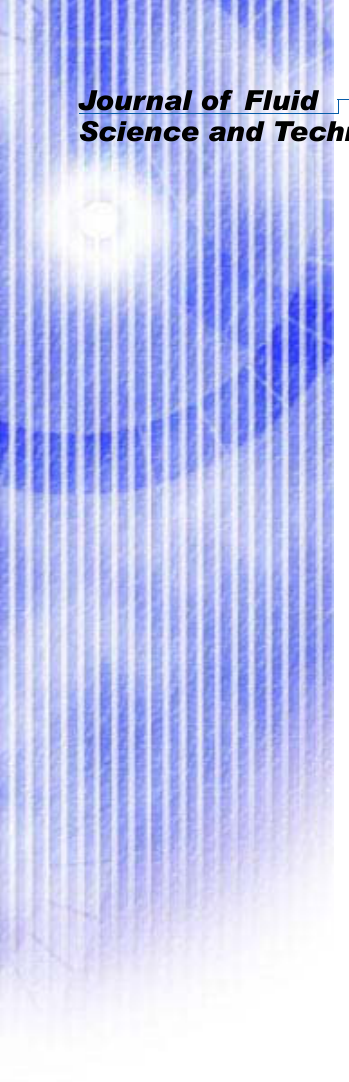
Fig. 5 Definition of the tip position of the thermal fumes based on temperature rise: δ T = 5, 10, and 30